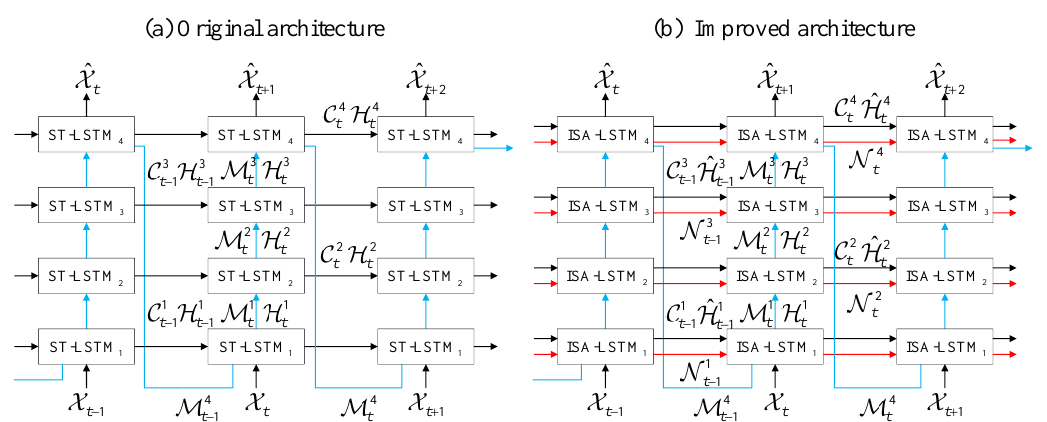
Figure 6. ( a ) The overall network architecture of the original PredRNN-v2. The spatiotemporal